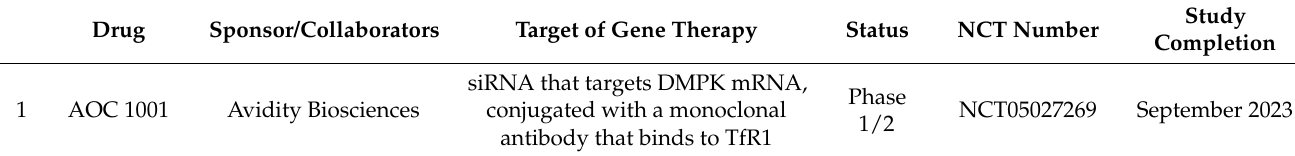
Table 5. Gene-specific therapies for DM tested in clinical